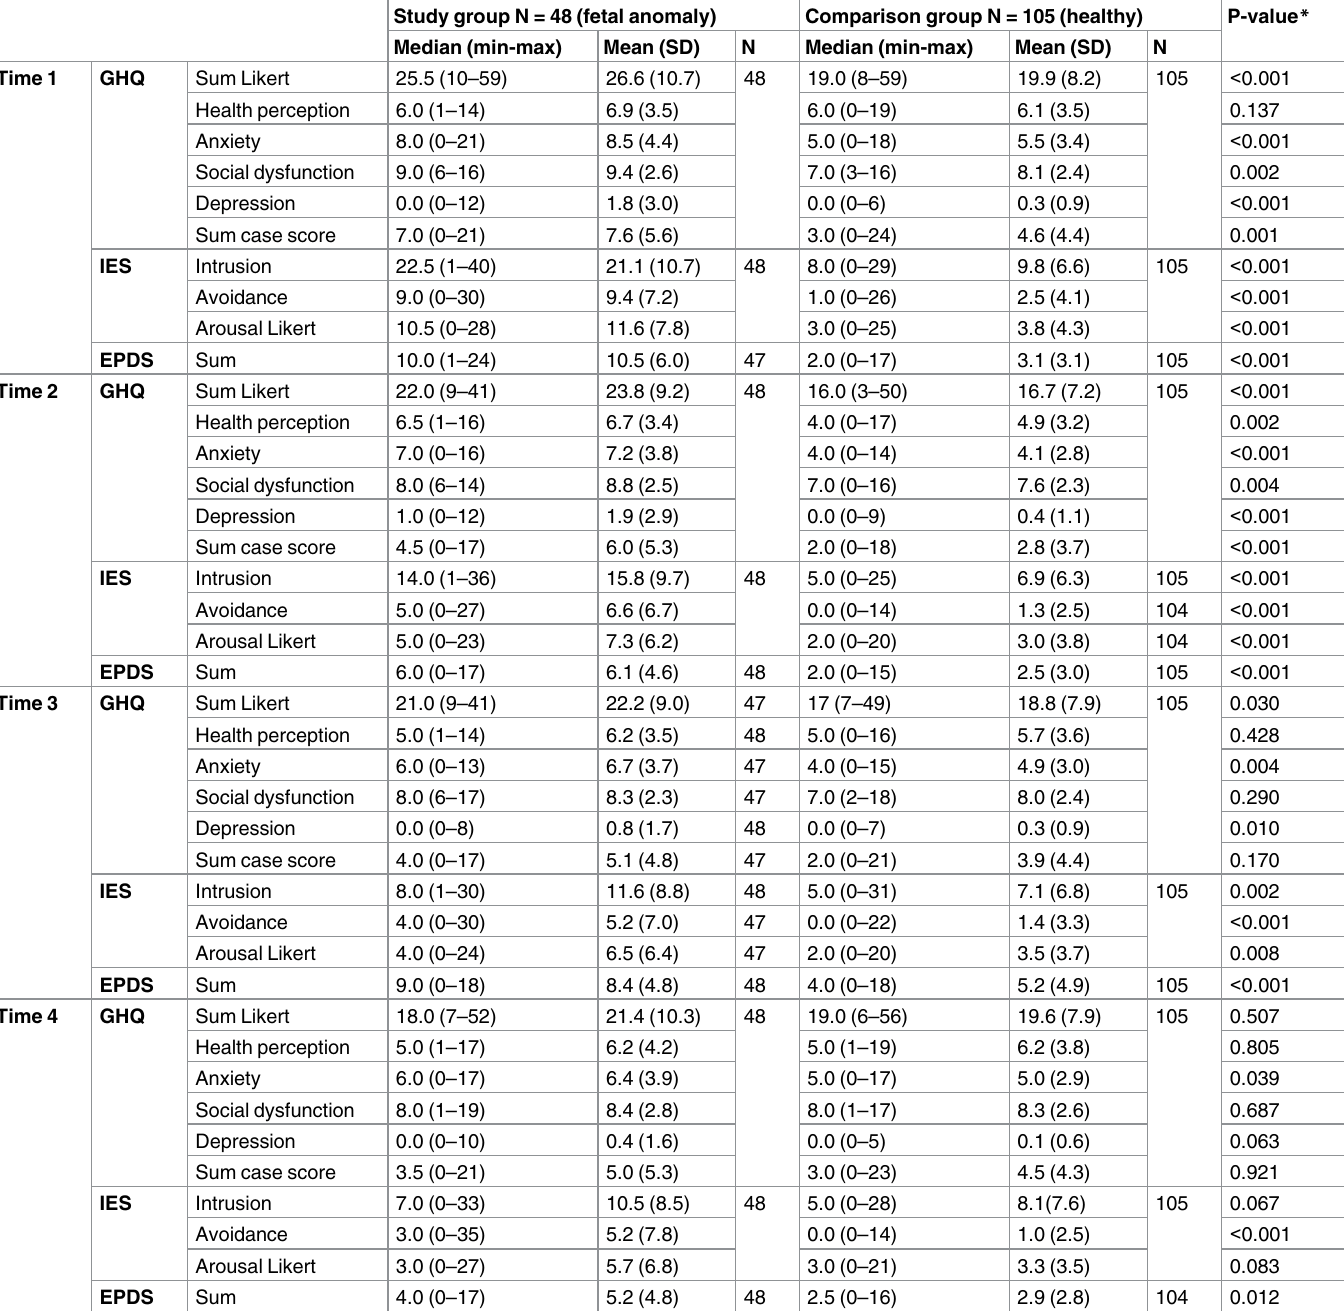
Table 2. Psychometric scores in women with and without a fetal anomaly, assessed at four points in